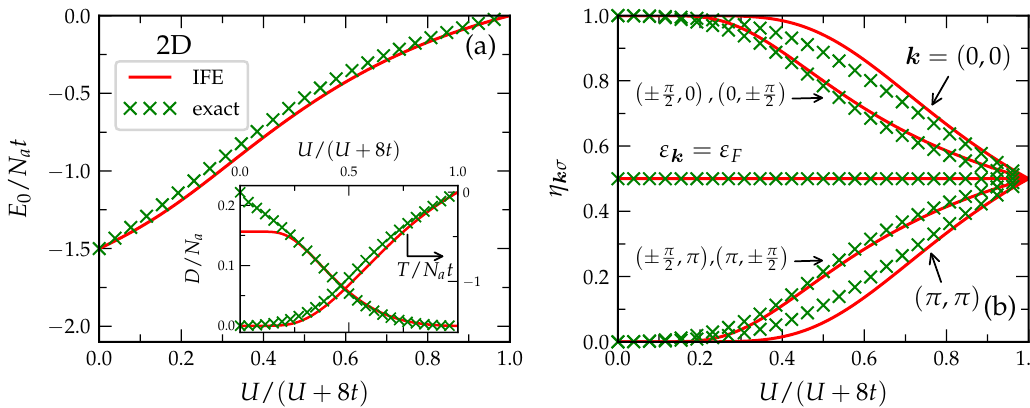
Figure 6. Ground-state properties of the periodic 2D Hubbard model on a 4 4 square lattice with × = N = 8 electrons and periodic boundary conditions. Exact numerical Lanczos diagonalizations N ↑ ↓ (green crosses) are compared, as a function of the Coulomb repulsion strength U / t with the linear independent-Fermion entropy (IFE) ansatz (red curves): ( a ) ground-state energy E 0 ; and ( b ) = η k natural-orbital occupation numbers η k . The average number of double occupations D and ↑ ↓ kinetic energy T are shown in the inset of ( a ). Reproduced with permission from Reference [72]. c (cid:13) American Physical Society.